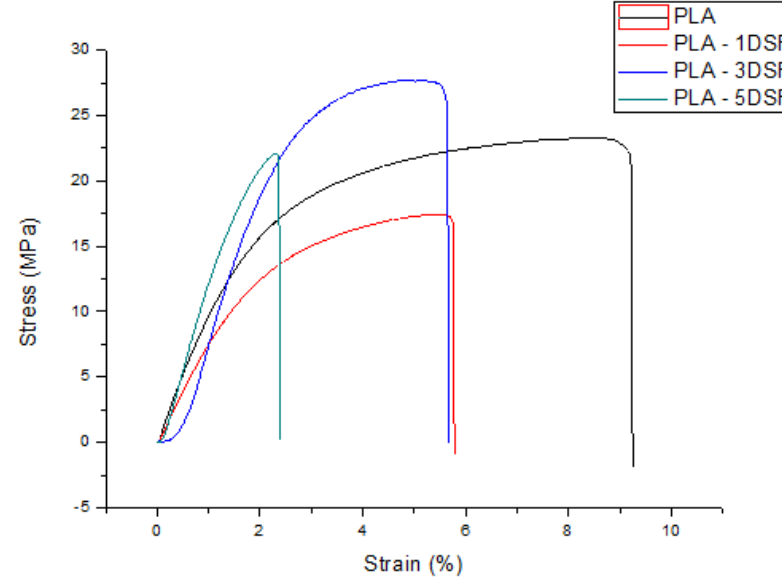
Figure 3: Stress-strain curve of PLA and PLA/DSF